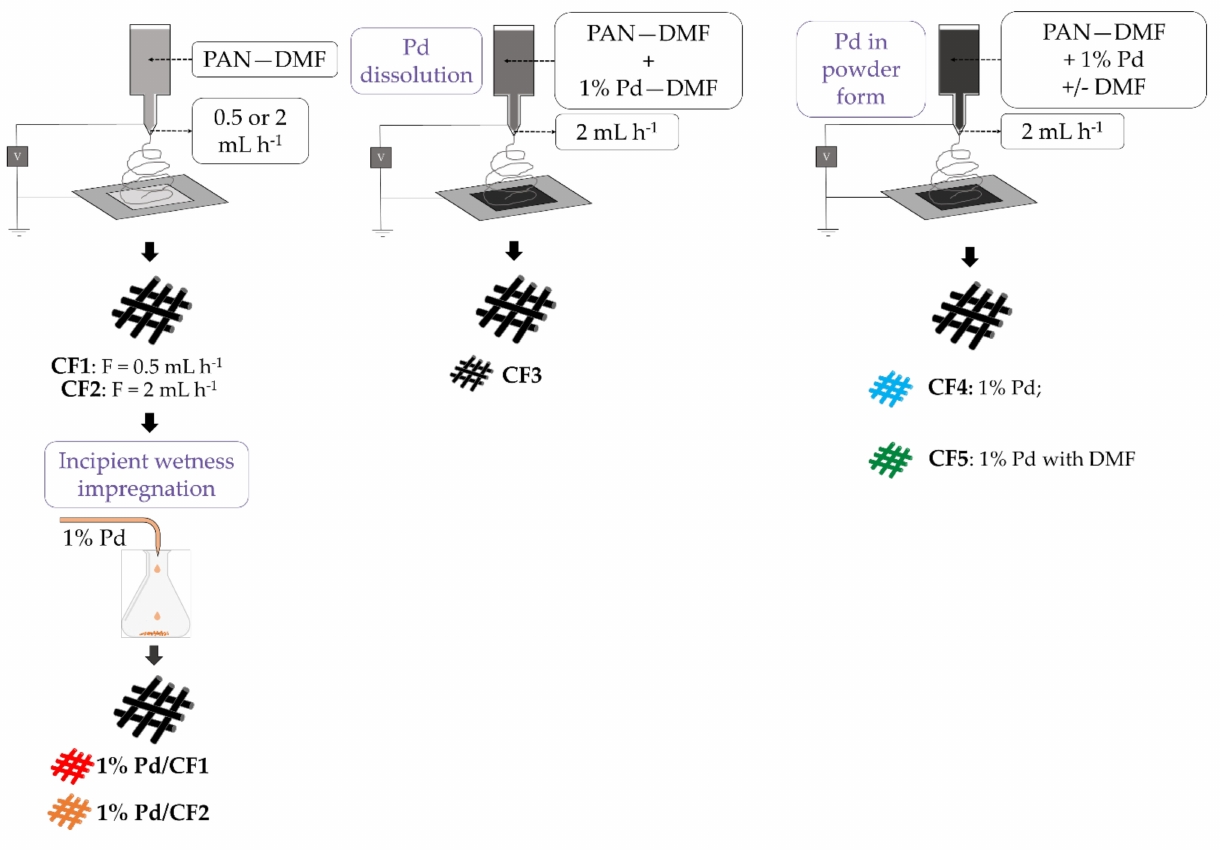
Figure 1. Schematic illustration of the synthesis of Pd-CFs